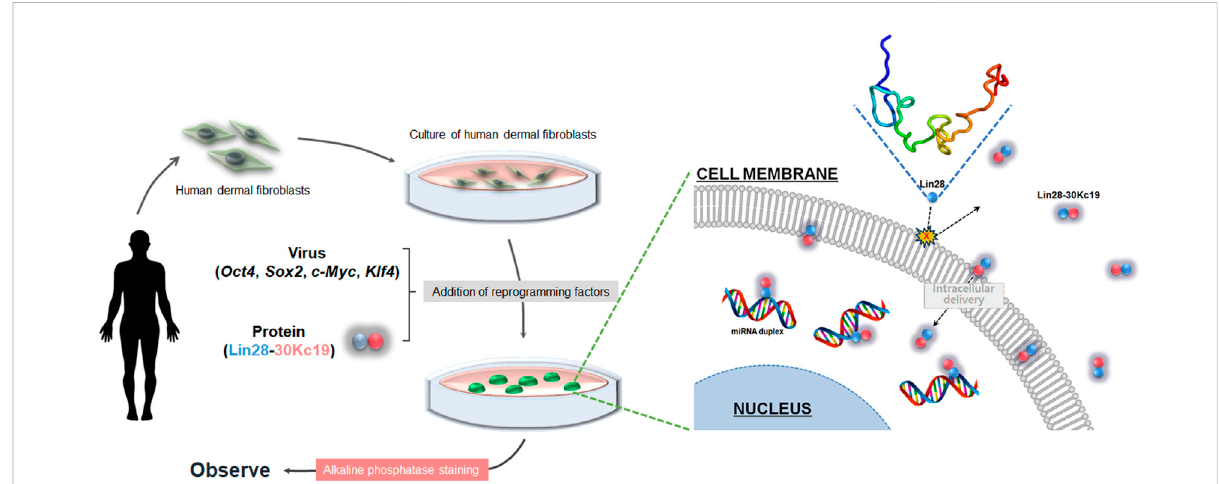
Overall schematicofhiPSC generation usingthe Lin28-30Kc19 protein.Addition of theLin28-30Kc19 proteinimproved theef fi ciency of hiPSC generation, due to the cell-penetrating and protein-stabilizing properties of the 30Kc19 protein, enabling intracellular delivery and maintenance of the stability of transcription factor,